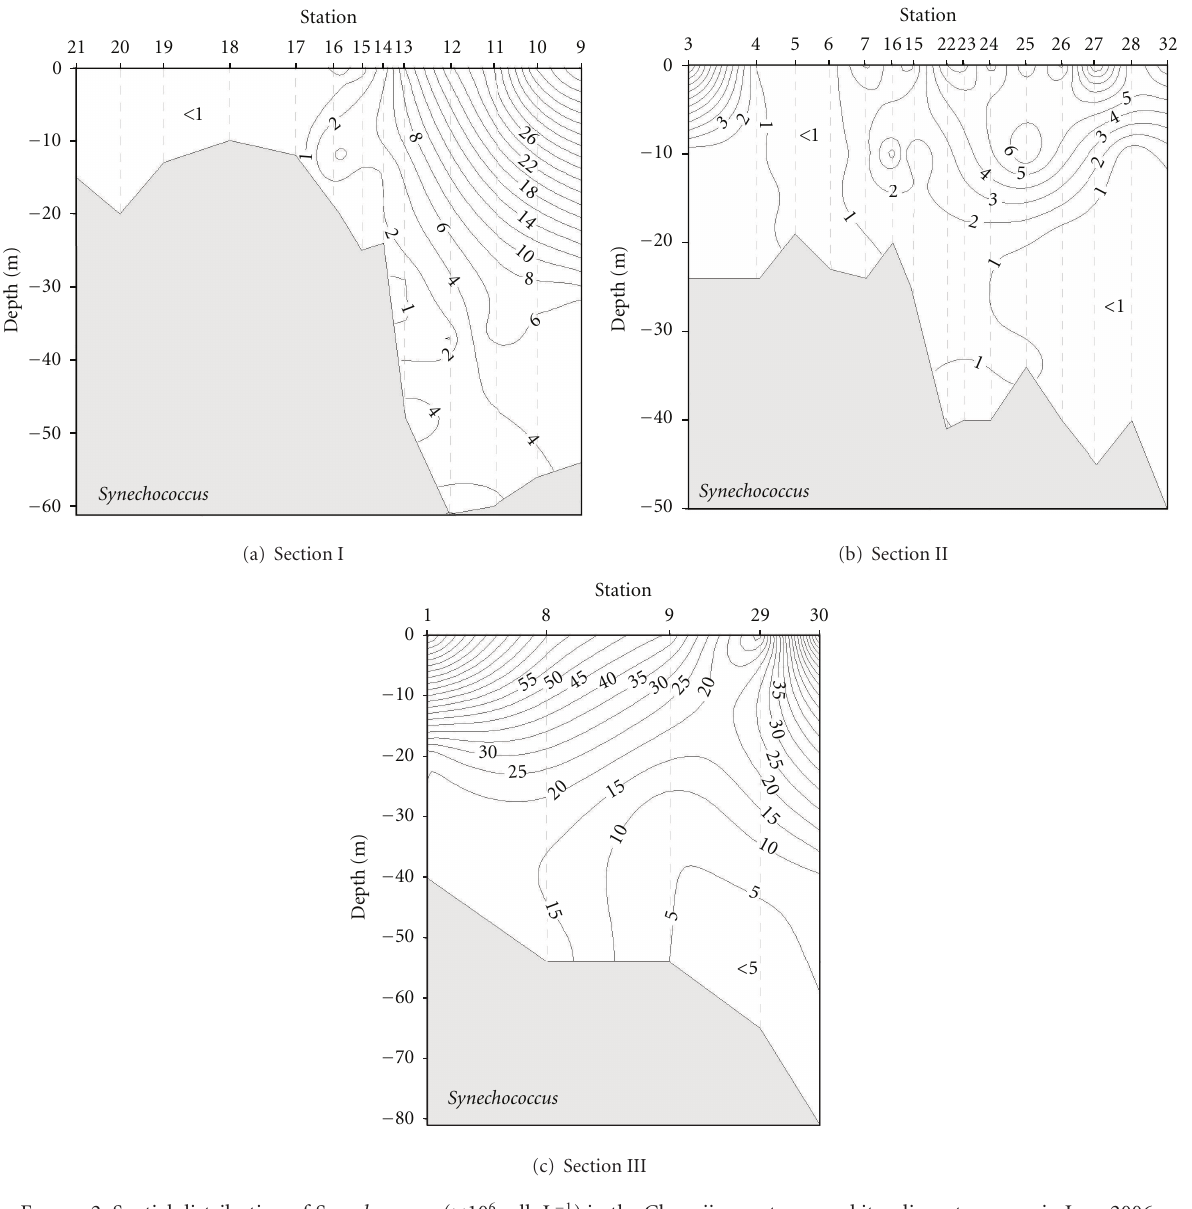
Figure 2: Spatial distribution of Synechococcus ( × 10 6 cells L − 1 ) in the Changjiang estuary and its adjacent sea area in June